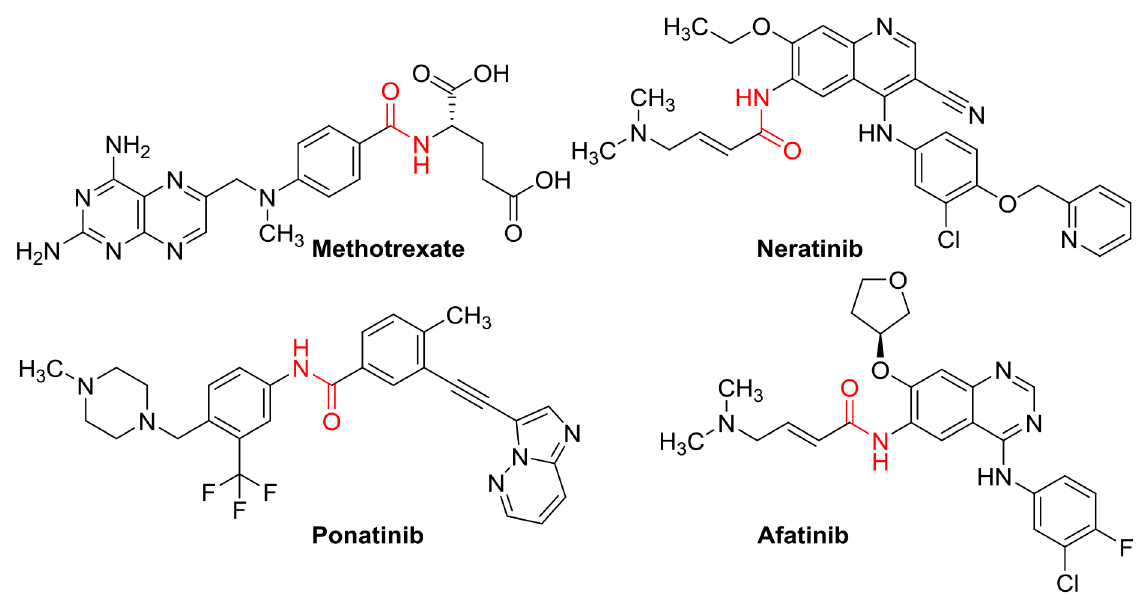
Figure 1: Representative examples of amide-containing drugs.